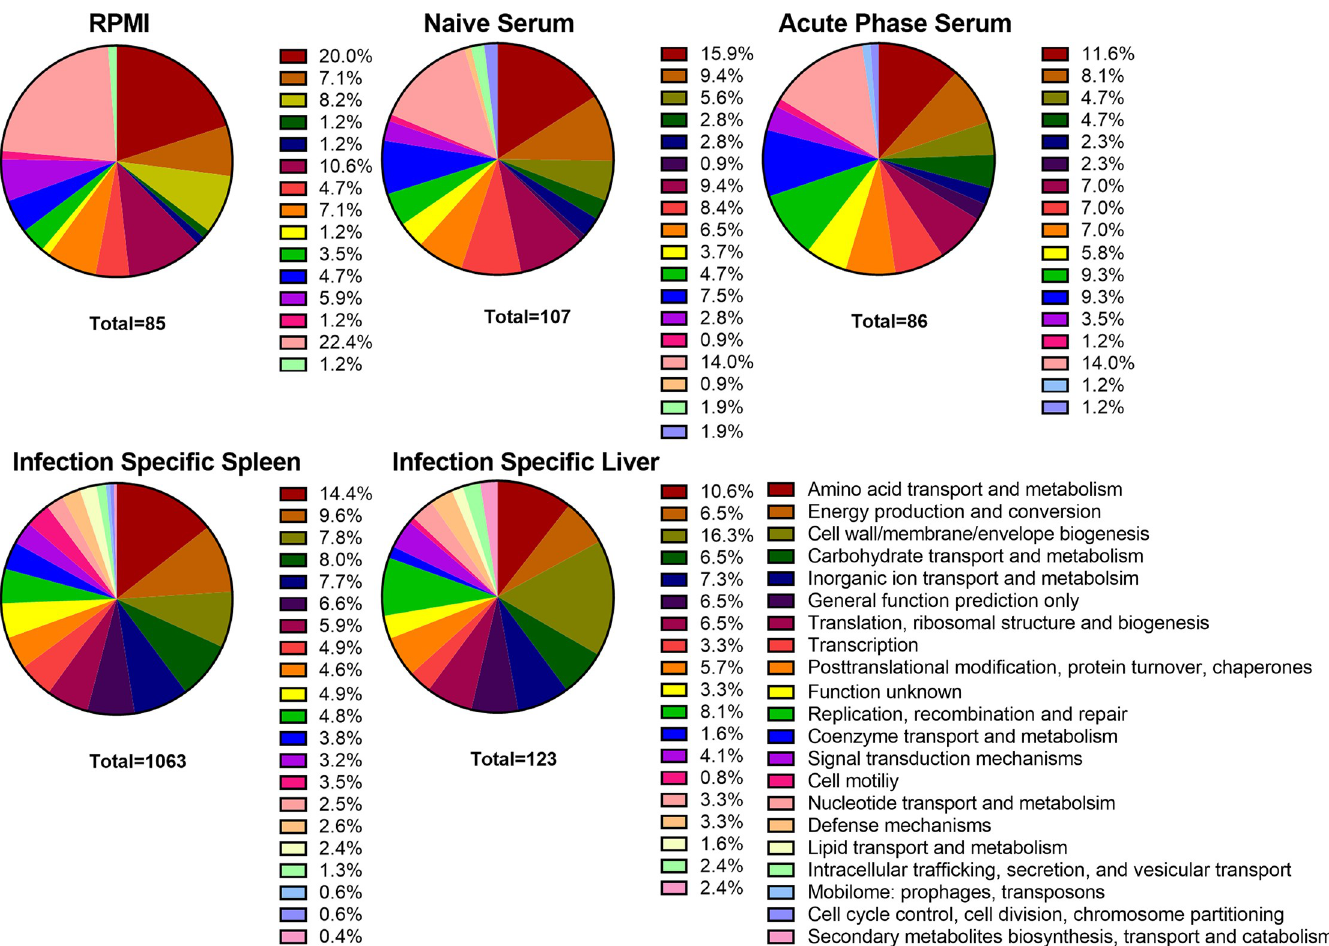
Fig 2. COG categories of Tn-Seq candidate fitness factors. The percentage of candidate P. mirabilis fitness factors required for growth in RPMI, 50% heat-inactivated naive mouse serum and 50% heat-inactivated acute phase mouse serum belonging to each Cluster of Orthologous Groups of proteins (COG). The percentage of candidate infection-specific P. mirabilis fitness factors during colonization of the murine spleen and liver 24 hours post-inoculation belonging to each COG, for which only genes identified during infection that had no defect in vitro are represented. The total number of fitness factors for each group with an identified COG category is listed under its respective pie